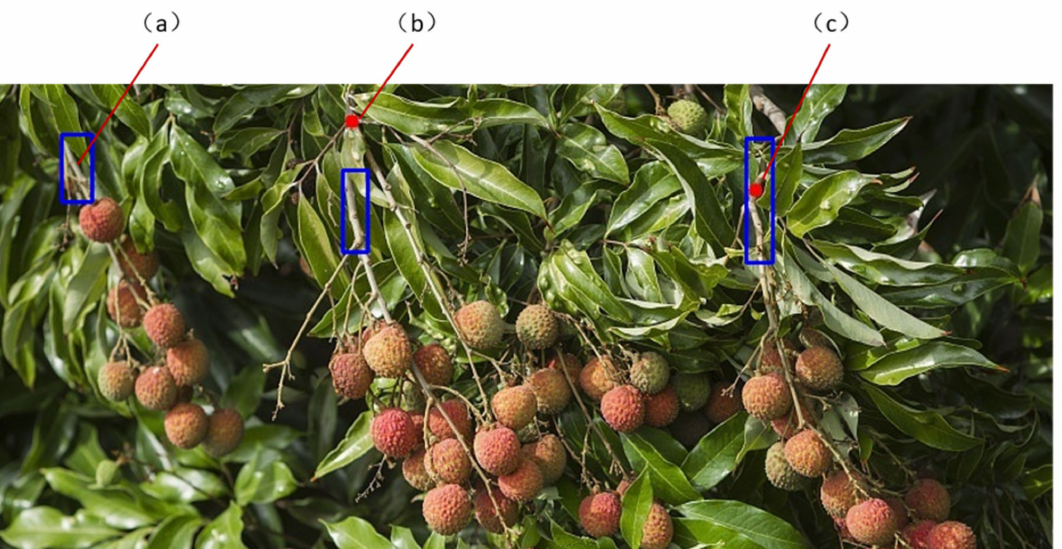
Figure 9. Example of picking points positioning. The blue box is the marking result of the main stem of litchi. The red dot is the picking point. Case ( a ) belongs to FN, case ( b ) belongs to FP, and case ( c ) belongs to